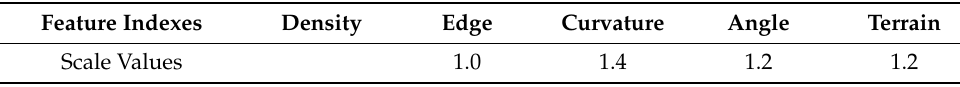
Table 4. Scale values of indexes for field area experiments.